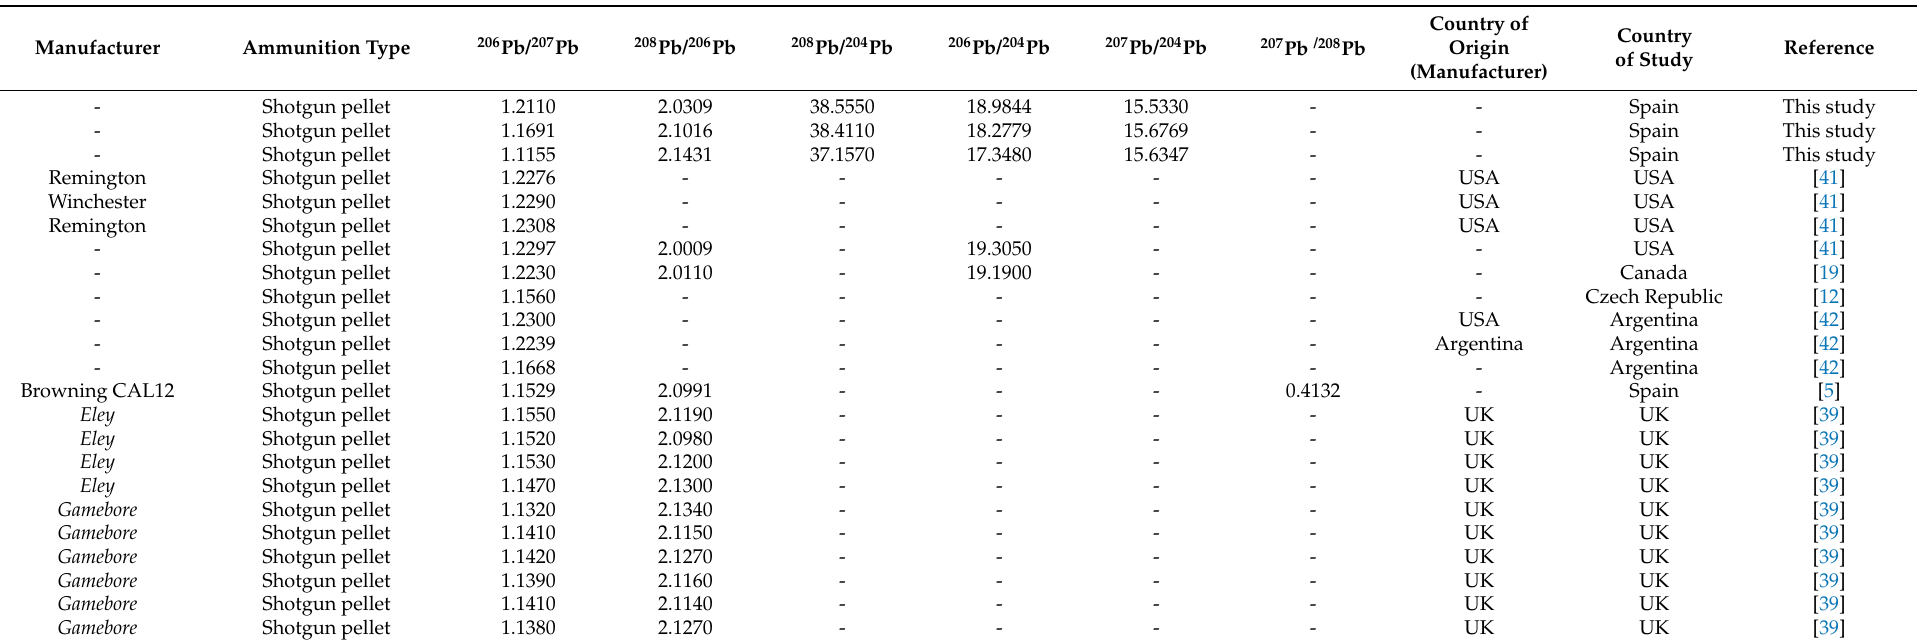
Table 2. The average lead isotopic signature of the studied shot pellets and shot pellets from different